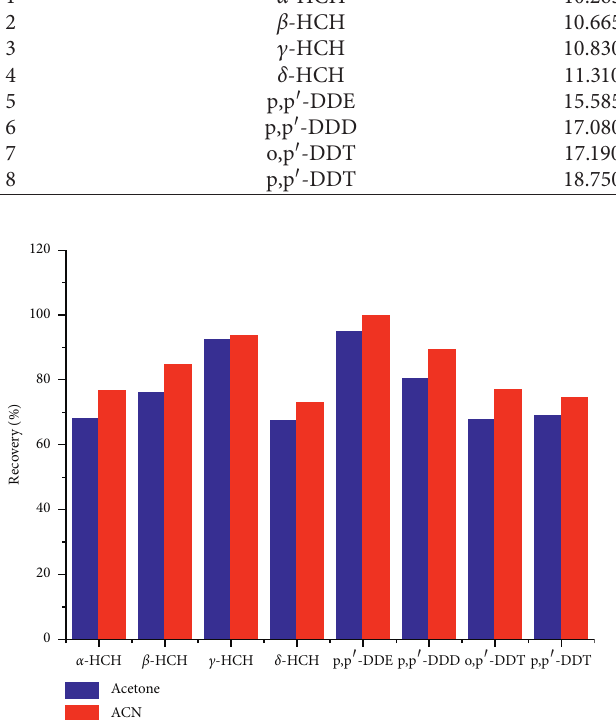
Figure 1: Extraction efficiency of two different organic solvents for